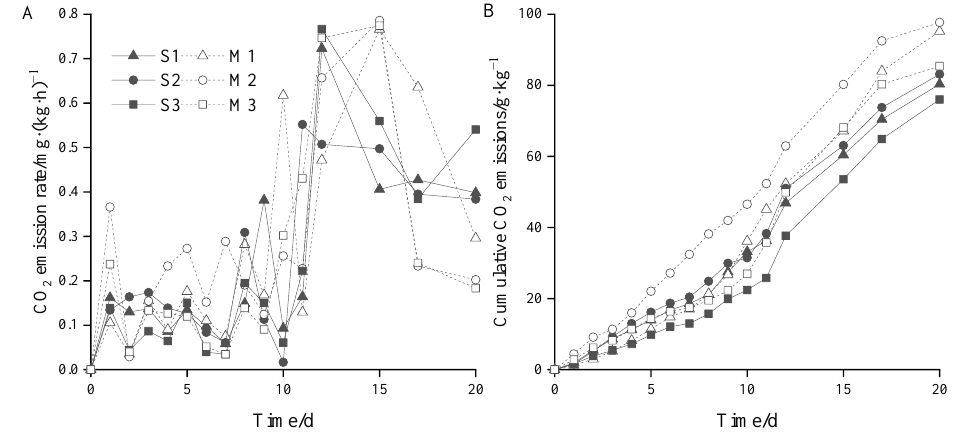
Figure 7. CO 2 emission rate ( A ) and cumulative CO 2 emissions ( B ) during composting. S1: pig manure + straw; S2: pig manure + straw + 3% SSP; S3: pig manure + straw + 6% SSP; M1: pig manure; M2: pig manure + 3% SSP; M3: pig manure + 6% SSP.